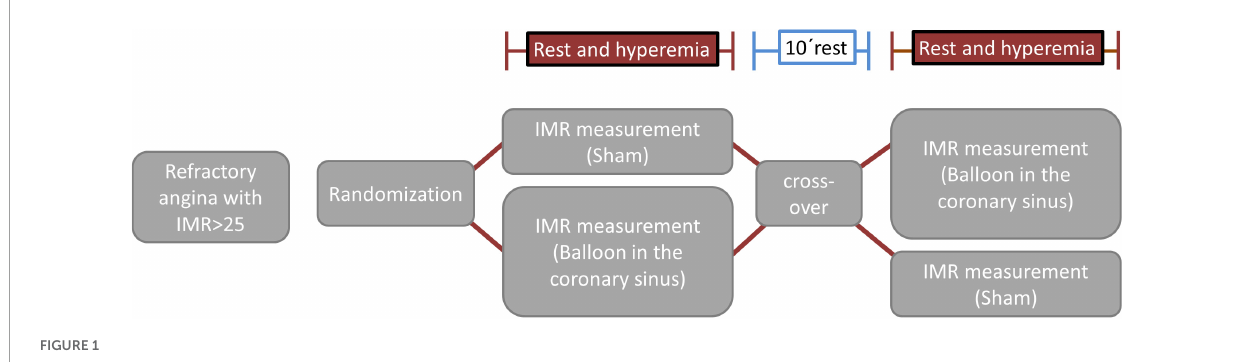
FIGURE1 Randomization.